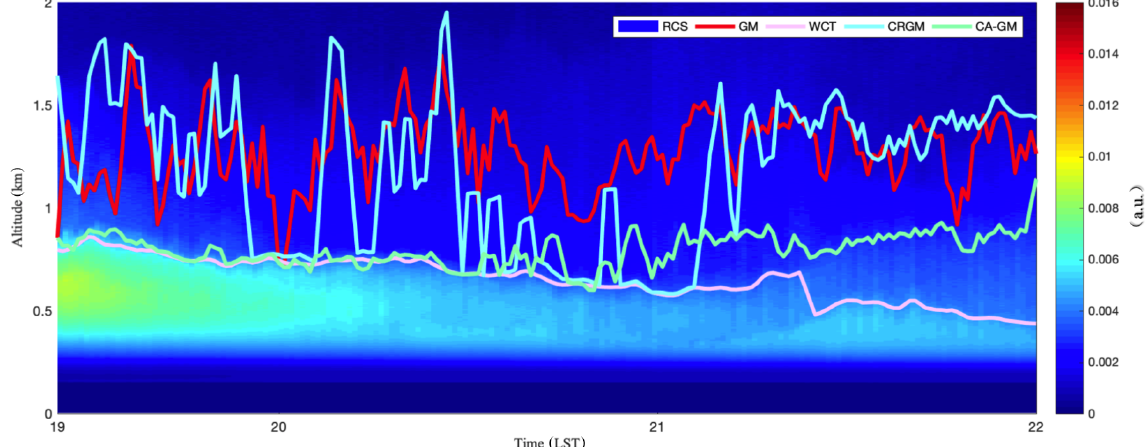
Figure 9. Time–height cross section of RCS with four NBLH retrieval methods on 6 April